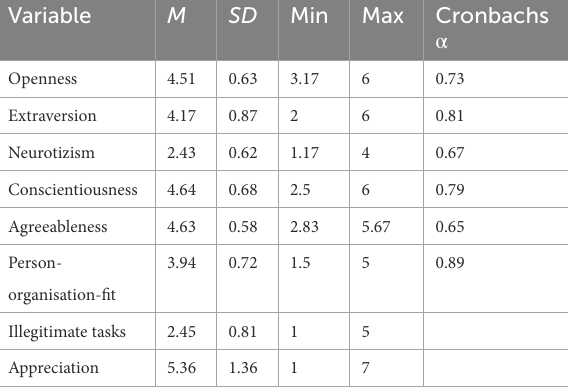
TABLE 2 Descriptive statistics and reliability of the scales.